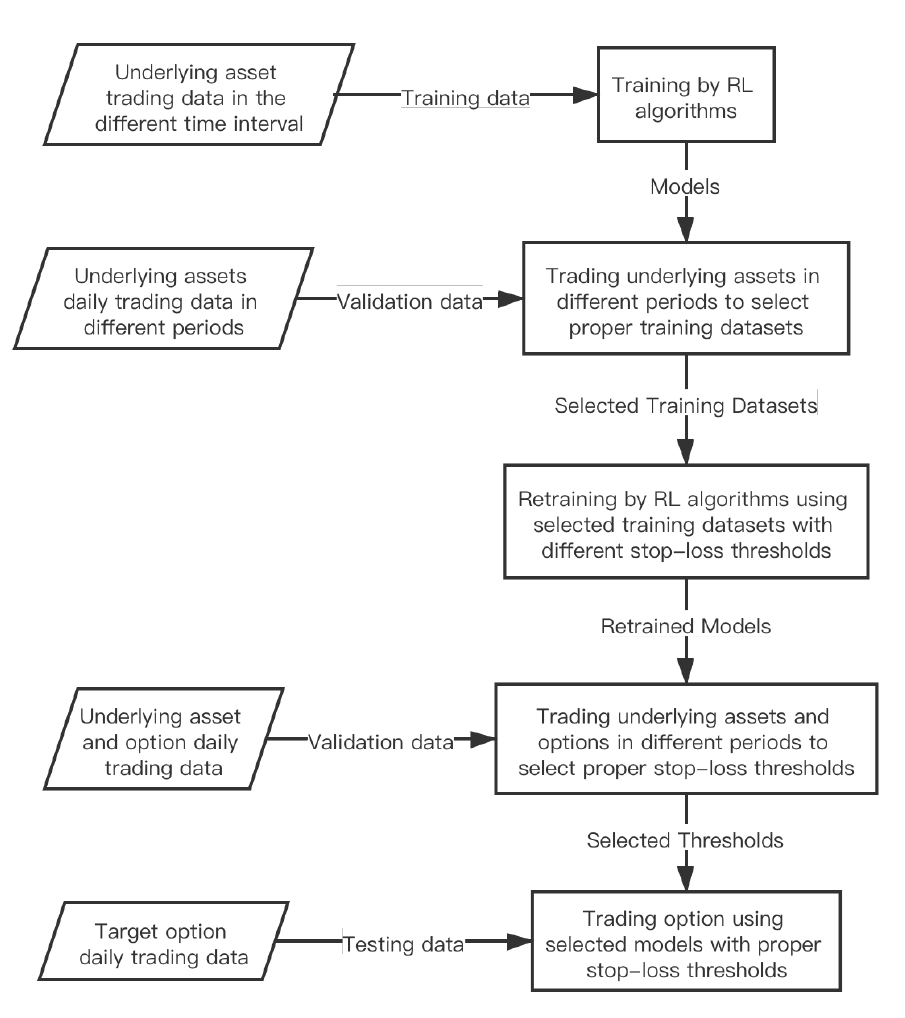
Figure 3. The flowchart of the OTRL